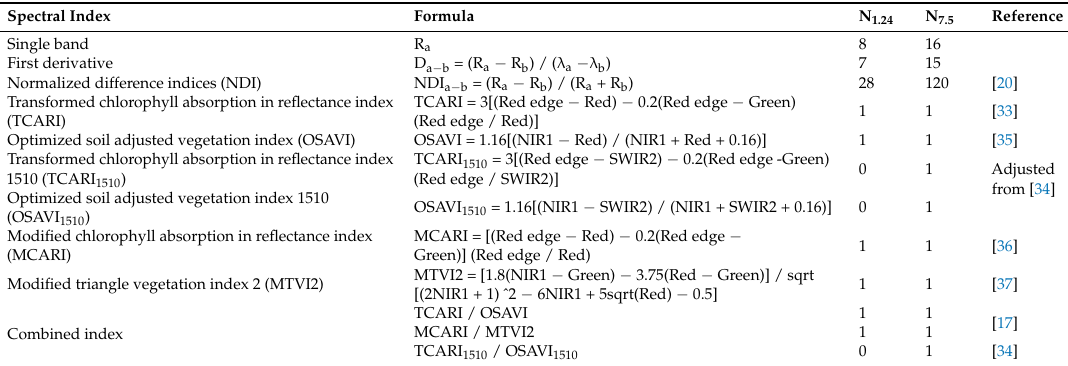
Table 2. Spectral indices used for estimation of foliar DigN in this study. Spectral bands in the formula are based on WorldView-3 (WV3) sensor bands. R a and λ a represents the reflectance and the average wavelength of a certain band. N 1.24 is the number of an index from WV3 1.24m spectra. N 7.5 is the number of an index from WV3 7.5m spectra or resampled ASD